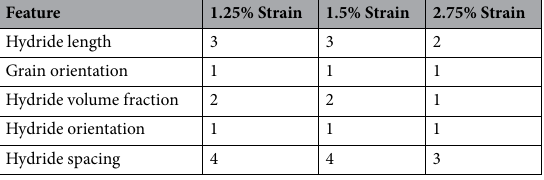
Table 5. Feature importance ranking for 3 random forest models.